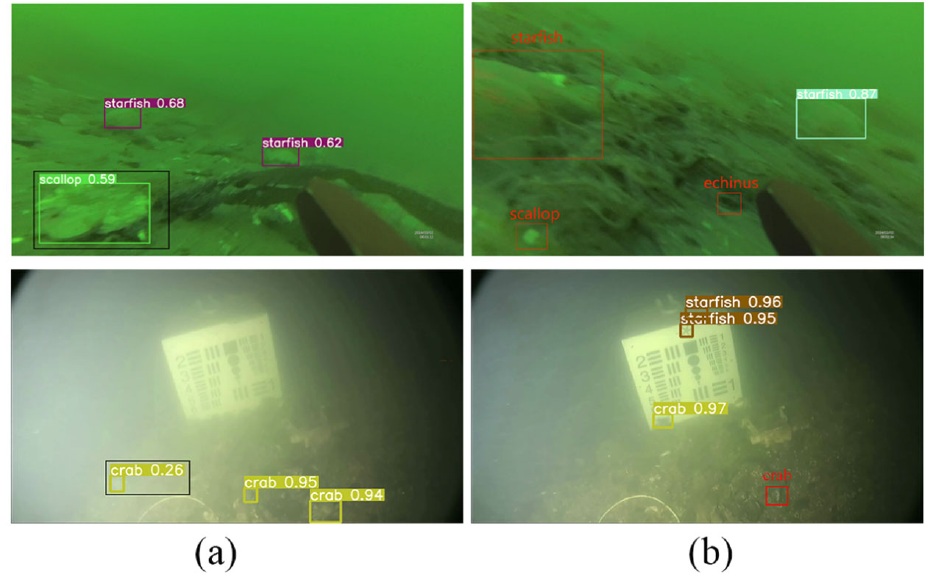
Figure 16. ( a ) Error detection of YOLOv7-AC in highly complex underwater environments ( left: marked in black boxes); ( b ) omission detection of YOLOv7-AC in highly complex underwater environments ( right : marked in red boxes).